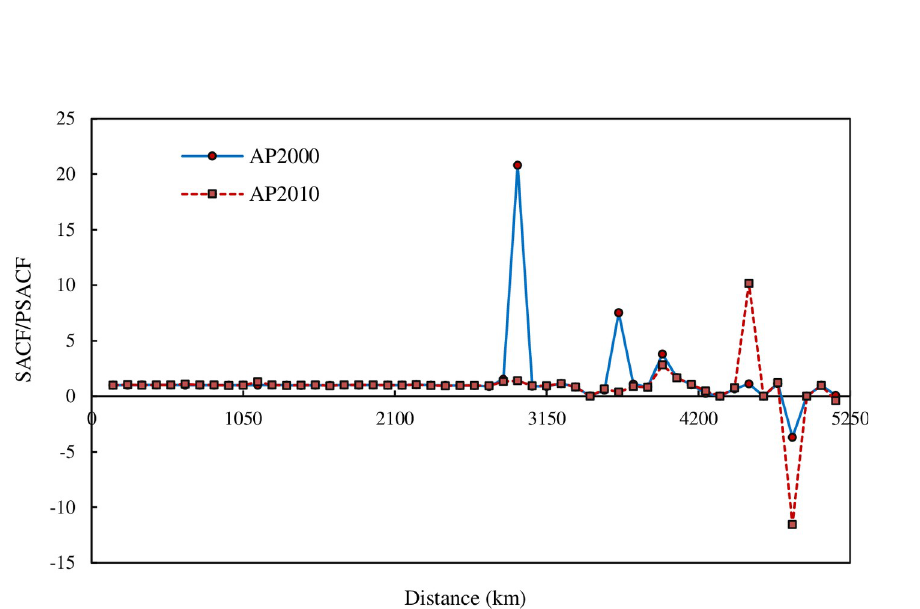
Fig 6. The ratios of SACF to PSACF based on correlation density for the main cities of China. ( Note : Inside the scaling ranges of spatial correlation dimension, the ratios of spatial autocorrelation function to the partial spatial autocorrelation function are stable; In contrast, outside the scaling range, the ratio curves fluctuate significantly. From 2000 to 2010, the scaling range extended from about 2850 to 3350 km.).